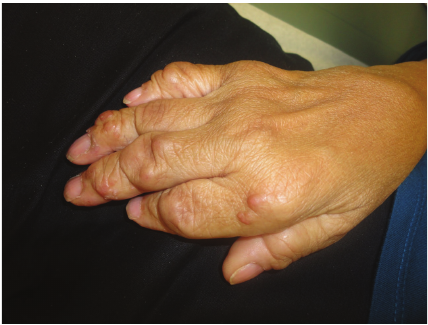
Figure 3: X-ray of the shoulder displaying multiple erosions of the acetabulum, humeral head, and acromioclavicular articulation.